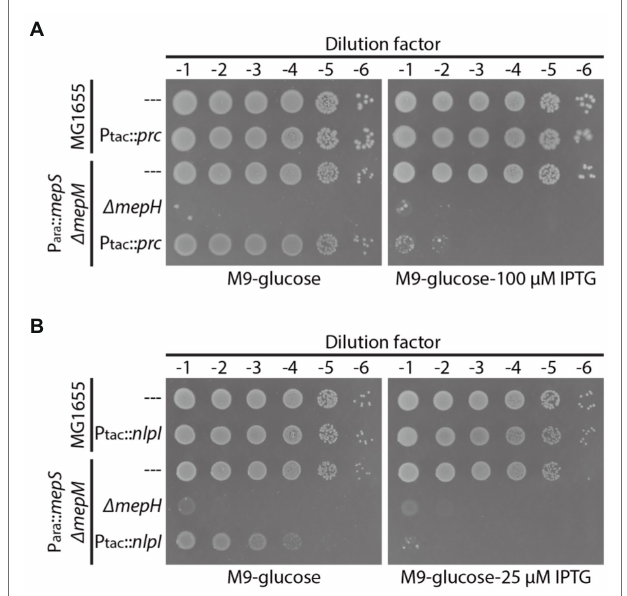
FIGURE 4 | Overexpression of prc or nlpI causes synthetic lethality with mepS and mepM mutations in minimal medium. (A) MG1655(attHKpWJ90, P tac ::empty), MG1655 (attHKpWJ186, P tac :: prc ), HC611[P ara :: mepS , Δ mepM ] (attHKpWJ90),